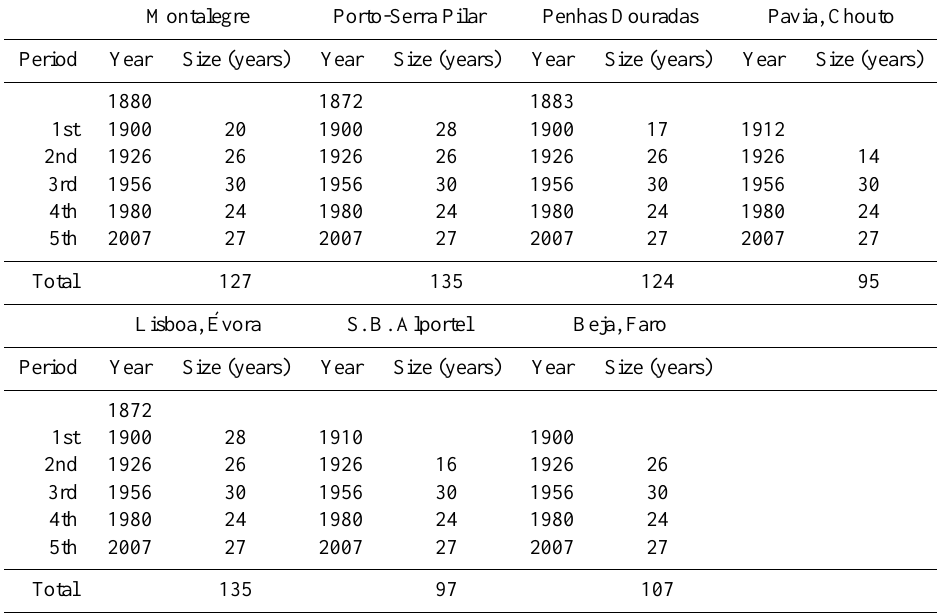
Table 1. Division into 4 or 5 sub-periods according to each time series total duration.